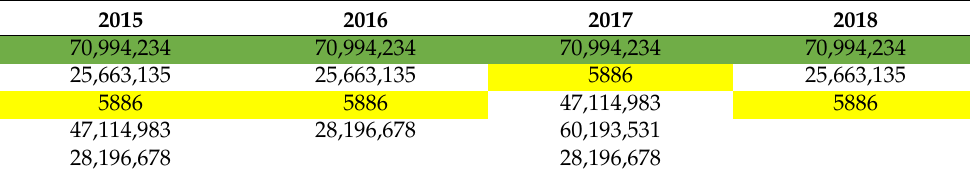
Table 31. Representation of companies in cluster (1, 1) in the years 2015–2018.